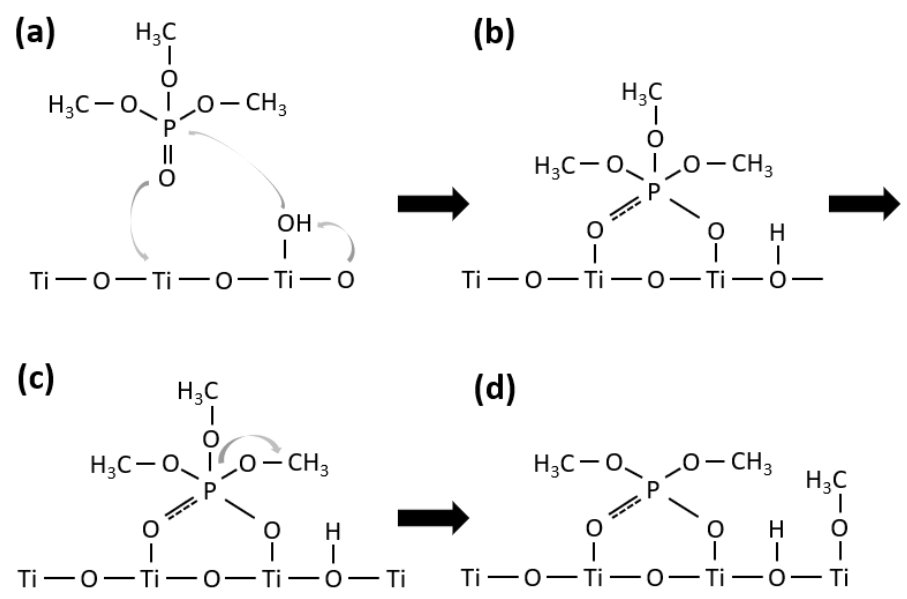
Figure 4. DRIFT spectra for the adsorption of TMP on UV100 ( a ) and Ti-600 ( b ), TEP on UV100 ( c ) and Ti-600 ( d ) at different time intervals. Positions and assignments for major absorption bands are